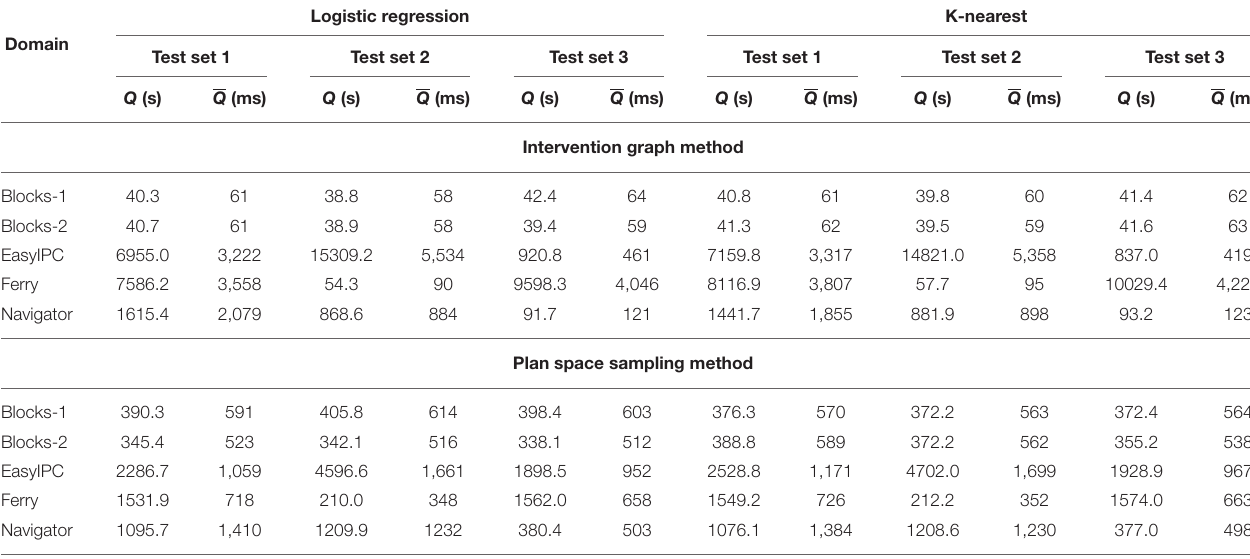
TABLE 7 | Total processing time in seconds ( Q ) for all Intervention problems in set 1, 2, and 3 and the mean processing time in milliseconds for each incrementally revealed observation ( Q ) for predicting intervention with logistic regression and k-nearest neighbor classifiers using features from the Intervention Graph and the Plan Space Sampling methods.